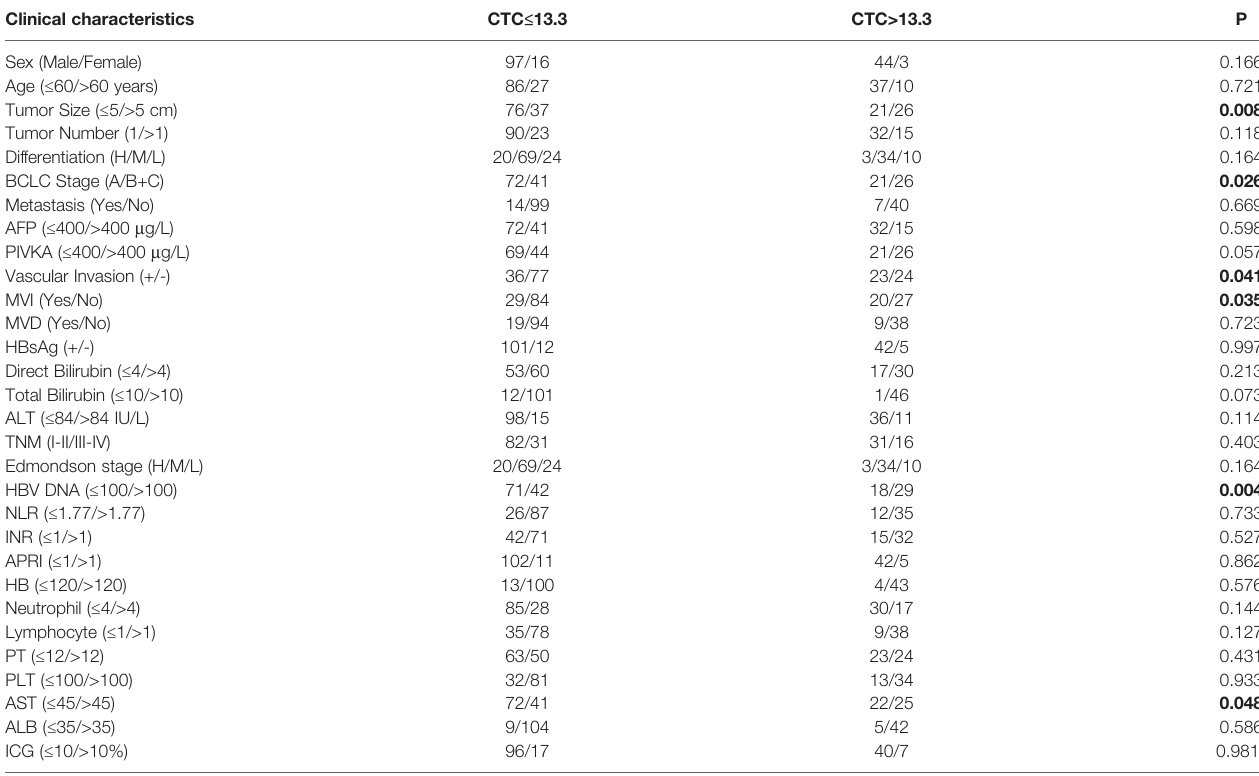
TABLE 1 | Study on the correlation between the total number of CTCs and the clinical characteristics of HCC. Clinical